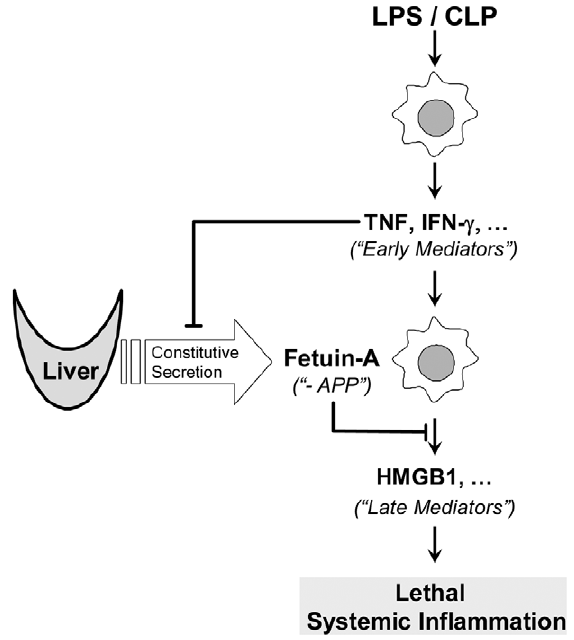
Figure 6. Hypothetical role of fetuin-A in lethal systemic inflammation. Fetuin-A is predominantly synthesized in, and consti- tutively secreted by the liver to maintain abundant basal circulating levels (e.g., 1100–1350 m g/ml in mice). In response to lethal endotox- emia (LPS) or sepsis (CLP), innate immune cells (such as macrophages) sequentially release early (e.g., TNF- a and IFN- c ) and late (e.g., HMGB1) proinflammatory mediators. These early proinflammatory cytokines (e.g., TNF- a , IFN- c and perhaps others) participate in the down- regulation of hepatic fetuin-A expression, allowing propagation of a rigorous inflammatory response manifested by excess accumulation of late proinflammatory mediators (such as HMGB1). On the other hand, fetuin-A functions as a negative regulator of the innate immune response by inhibiting LPS- or IFN- c -induced HMGB1 release in macrophages.